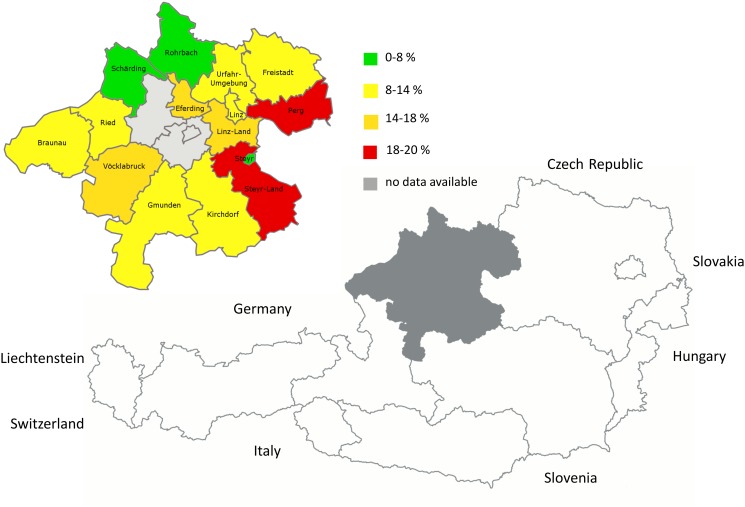
Geographical map of Upper Austria.A detailed analysis of seroprevalences [%] marked in green, yellow, orange and red of all districts is shown. Areas in grey are those with no available data. Copyright: The map of Austria is adapted from Statistik Austria and modified by Niklas N., http://www.statistik.at/web_de/services/interaktive_karten; The map of Upper Austria is adapted from wikipedia, author AleXXw and modified by Hofmann M., http://de.wikipedia.org/wiki/Datei:Karte_A_Ooe_ohne.svg